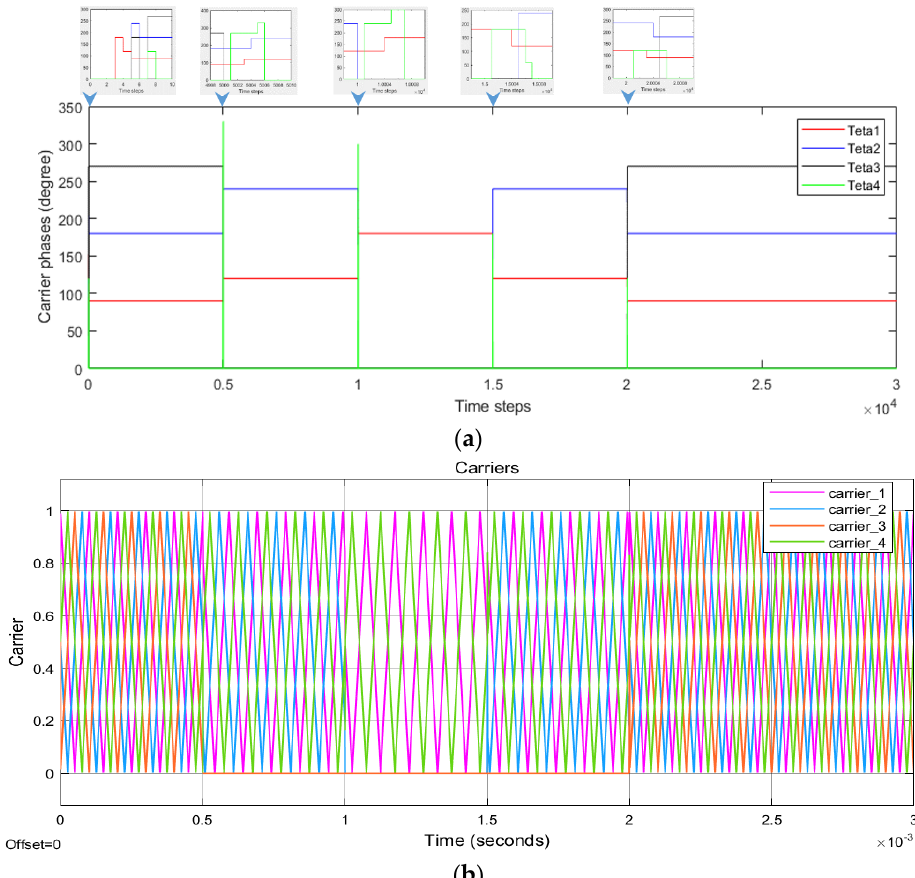
Figure 15. Multiple reconfigurations of four interleaved carriers using DSA-PSC method, ( a ) carrier phases; ( b ) phase- shifted carriers.